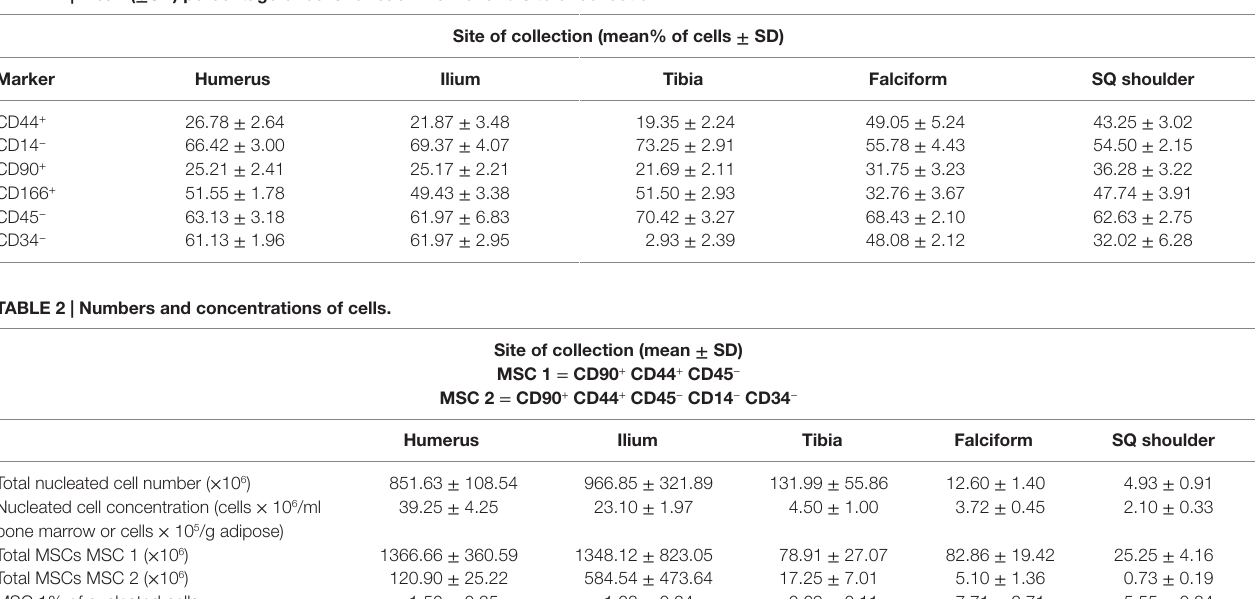
TaBle 1 | Mean ( ± sD) percentage of cells for each marker and site of